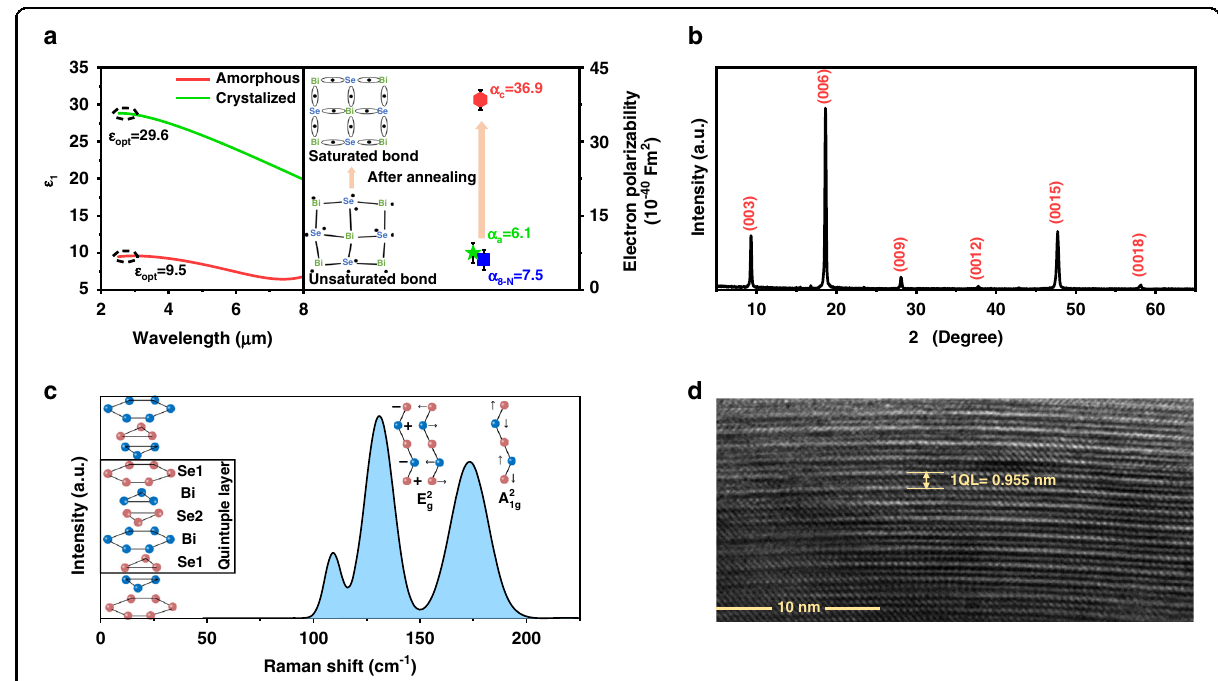
Fig. 2 Optical dielectric constant and crystal structure of Bi 2 Se 2.4 thin fi lm. a The increase in ε opt and α e caused by the transition from amorphous to crystalline, where the inset is a schematic diagram of the transformation of saturated bonds to unsaturated bonds. b The XRD spectrum, c Raman spectrum, and d HRTEM image of crystalline Bi 2 Se 2.4 thin fi